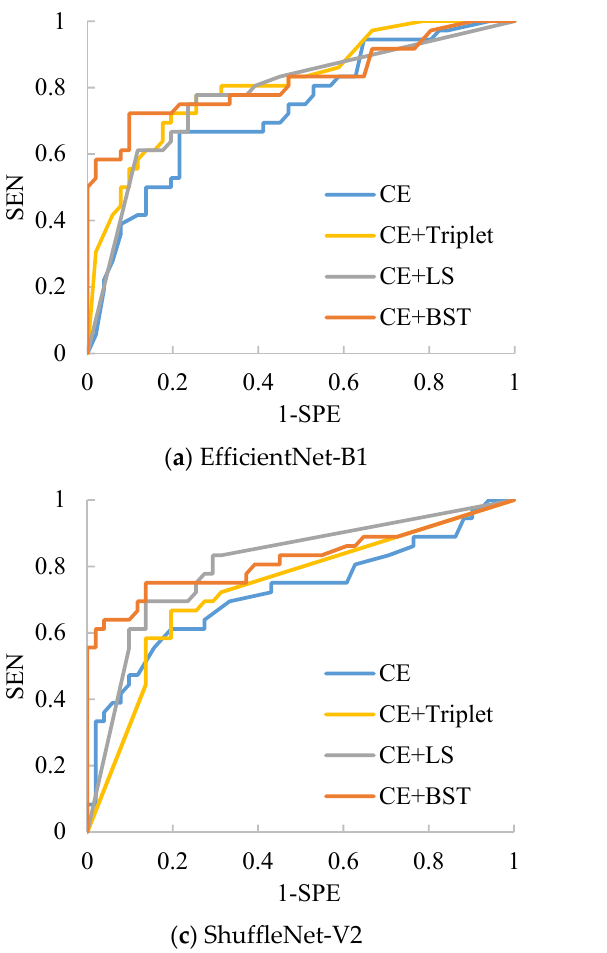
Table 10. The metrics for MobileNet-V3-Small on the osteosarcoma histology image dataset.